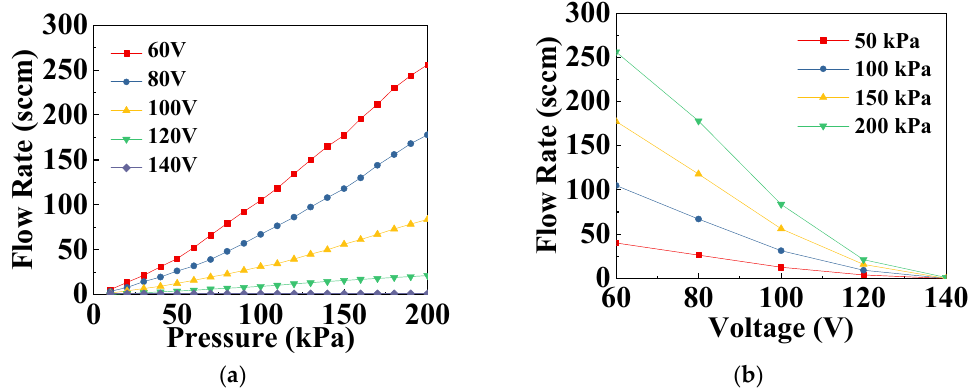
Figure 8. Measured flow rate as a function of ( a ) differential pressure under various actuation voltages and ( b ) actuation voltage under various differential pressures.